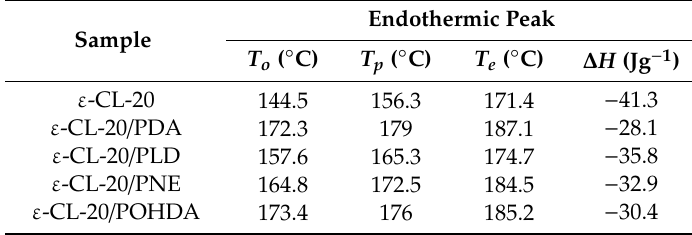
Table 3. Thermal analysis data of epsilon-CL-20 ( ε -CL-20) and di ff erent composites.